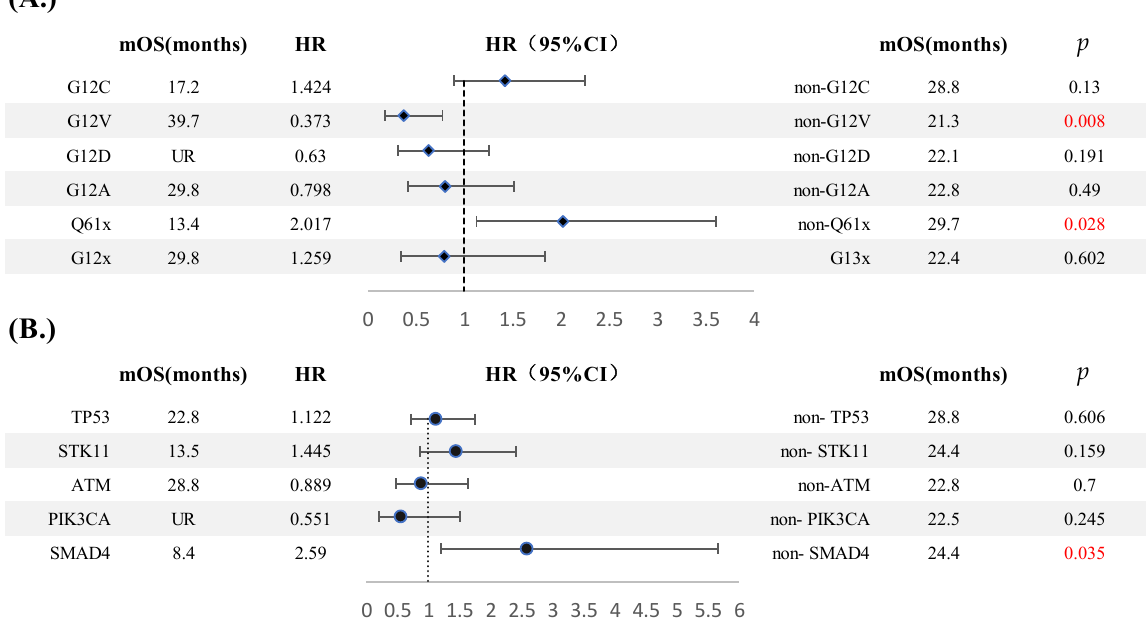
Figure 6. Forest plot of outcomes in KRAS subtypes ( A ) and co-mutations ( B ). ( p < 0.05, statistical significance; p < 0.001, significant statistical significance, red indicates. p ≥ 0.05, no statistical significance, black indicates).